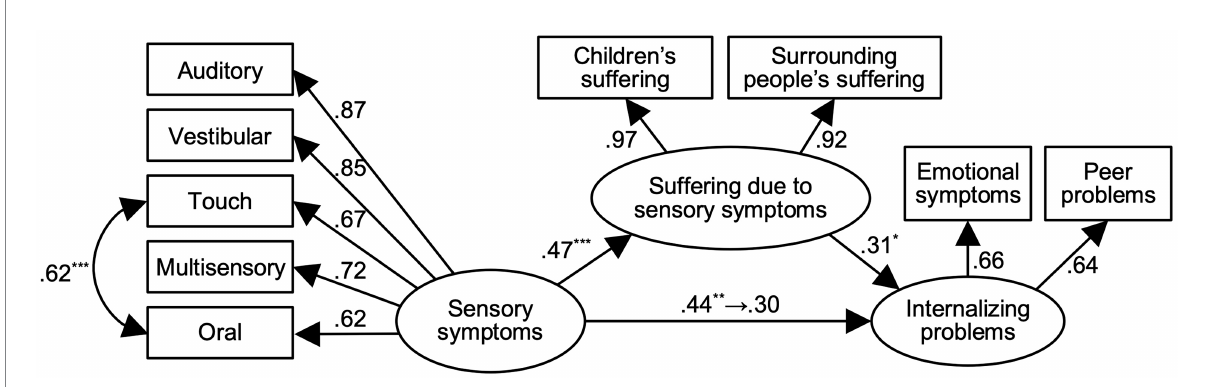
FIGURE 2 SEM was performed for children attending regular classes ( n = 69), χ 2 (2) = 24.35, p = 0.71, CFI = 1.00, RMSEA = 0.00. Autistic traits were controlled. The results of significance test only for path coefficients between sensory symptoms, suffering due to sensory symptoms, and internalizing problems and correlation coefficient between Touch and Oral were described. * p < 0.05, ** p < 0.01, *** p <